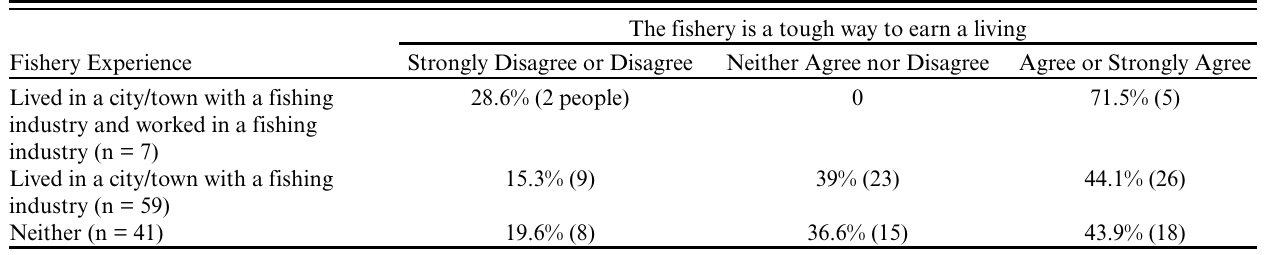
The fishery is a tough way to earn a living